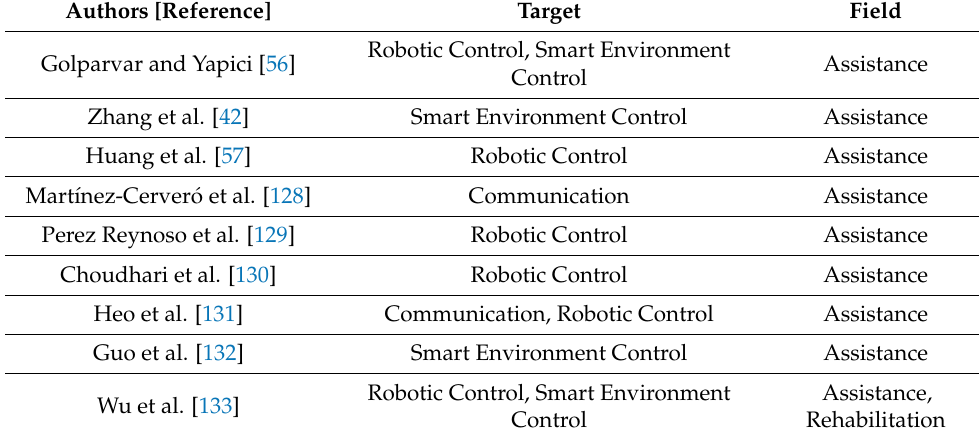
Table 5. EOG-based